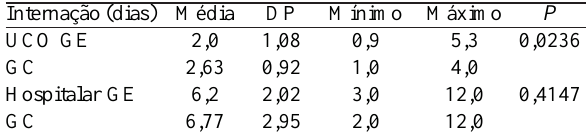
Tabela 5. Internação na unidade coronária e hospitalar dos